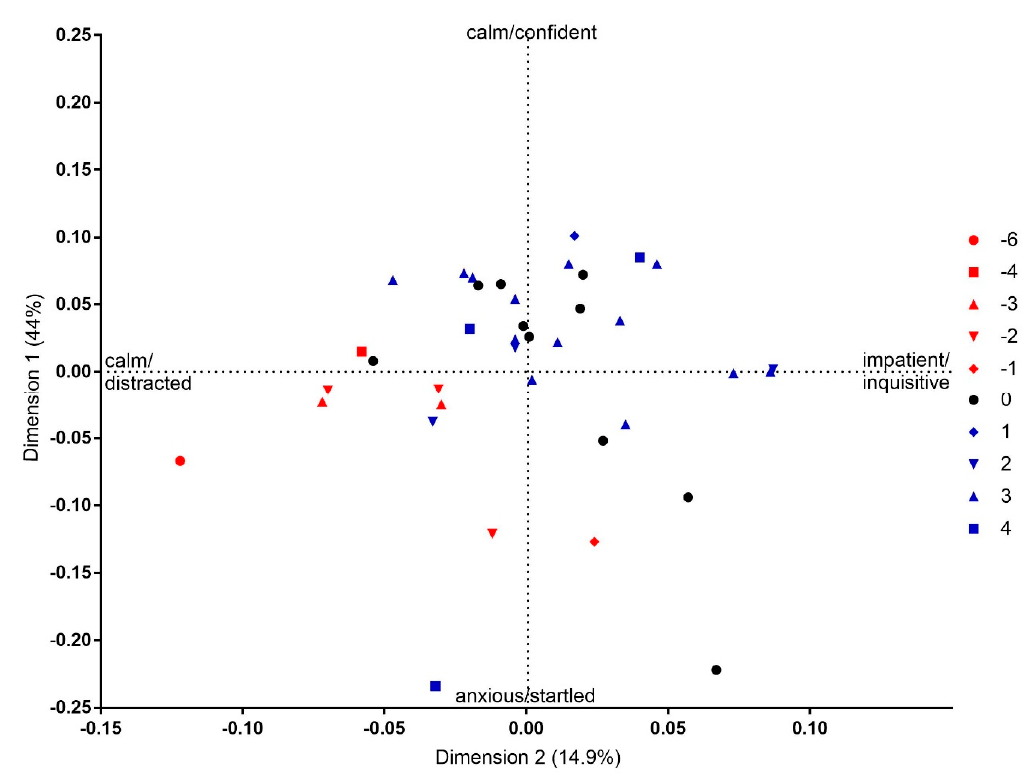
Figure 3. Score plot of video clips labelled by cumulative keeper activity scores. The x and y axis reflect the General Procrustes Analysis scaling values for the relative difference between the assessment of keeper action scores.